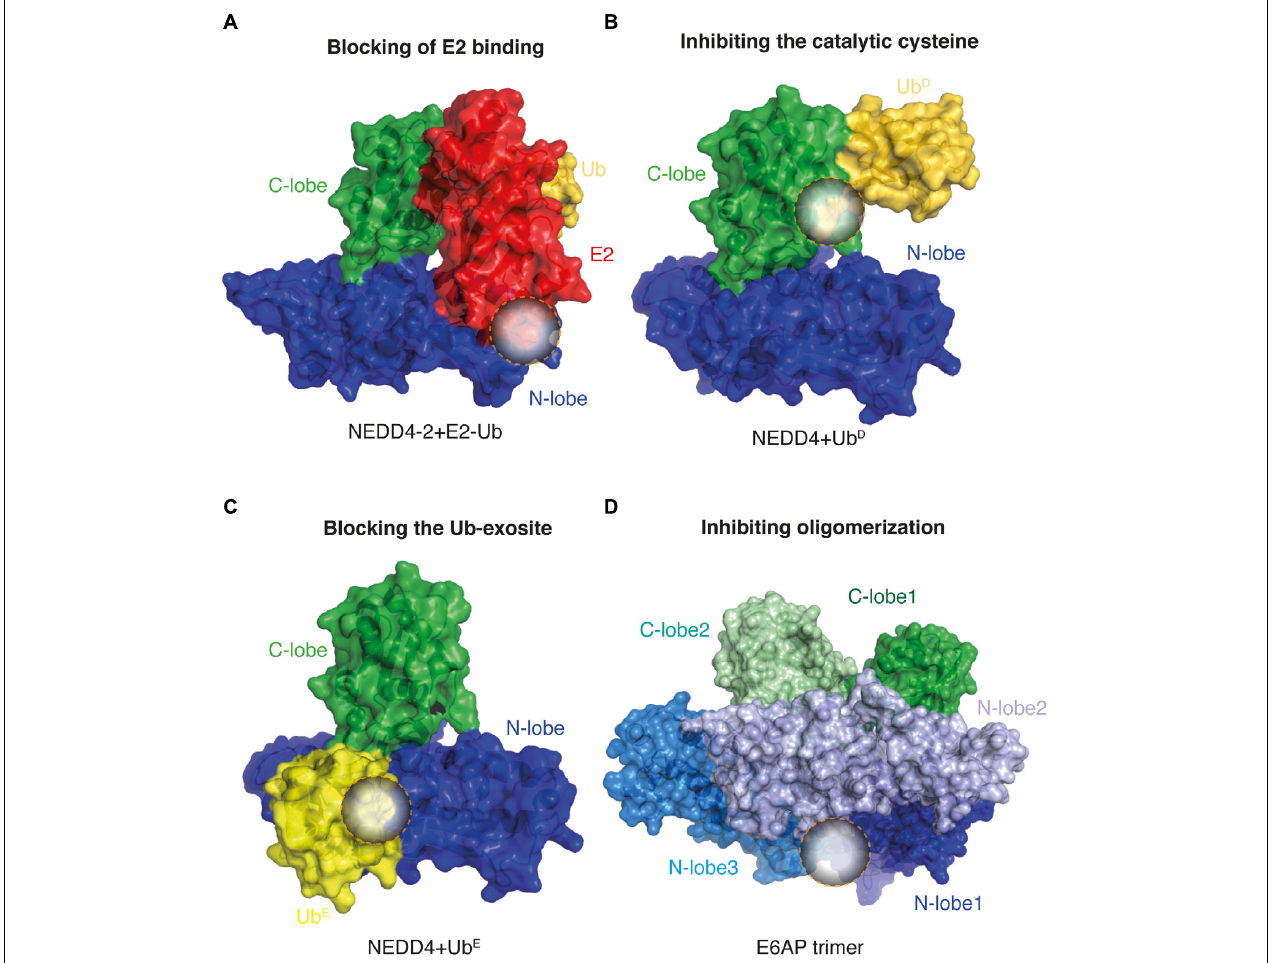
FIGURE 1 | Predicted inhibitory targets for HECT E3s activity. Surface representations of known crystal structures of HECT E3s. In circles are highlighted the possible binding sites for small molecules. (A) Blocking the E2 binding: HECT NEDD4 − 2 in complex with Ub (gold)-loaded E2 (red; PDB 3JVZ). (B) Inhibition of the catalytic cysteine: Ub (Ub D , gold)-loaded HECT NEDD4 complex; PDB 4BBN. (C) Blocking the Ub exosite: HECT NEDD4 in complex with Ub bound to the exosite (Ub E , yellow; PDB 4BBN). (D) Inhibition of the oligomerization: HECT E6AP trimeric complex (1D5F). C-lobes and N-lobes are depicted in green and blue, respectively.